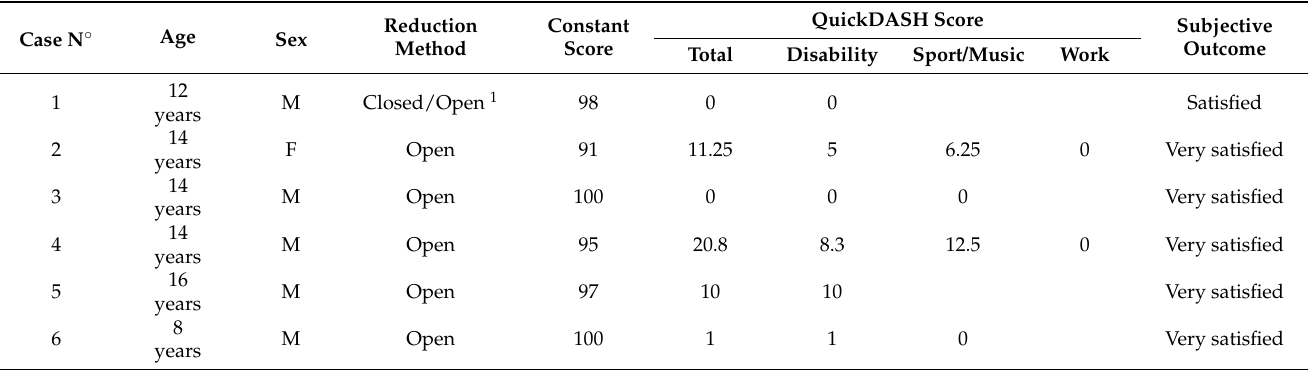
Table 1. Outcome with 2-year follow-up after open reduction, internal plate fixation and early (mean 4 months postoperative) plate